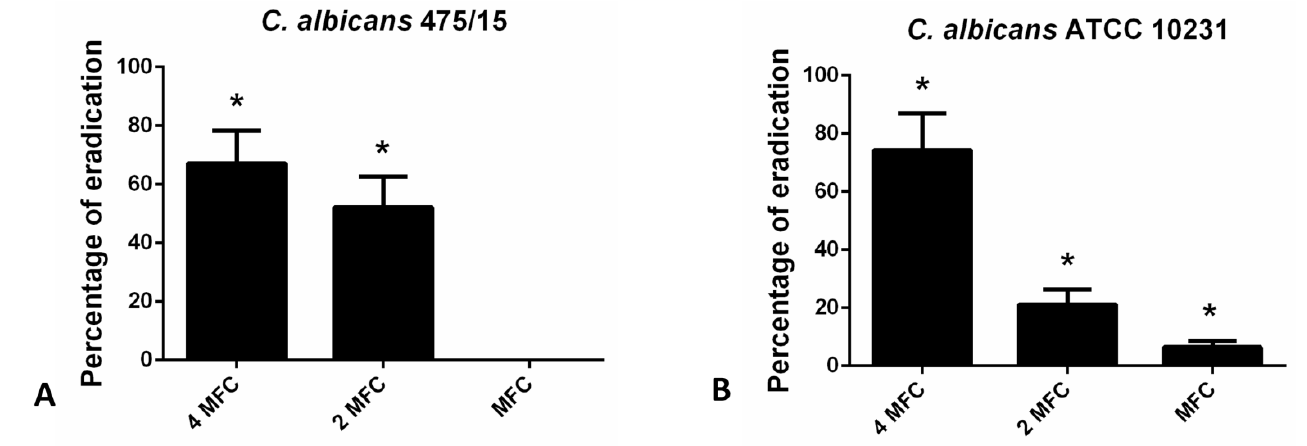
Figure 3. Eradication of 24 h old ( A )- C. albicans 475/15; ( B )- C. albicans ATCC 10231 biofilms after application of hesperetin in concentrations MFC (0.330 mg/mL), 2 MFC (0.660 mg/mL) and 4 MFC (1.320 mg/mL). Mean values of triplicate independent experiments ± SD are shown, * p < 0.05 compared to control.